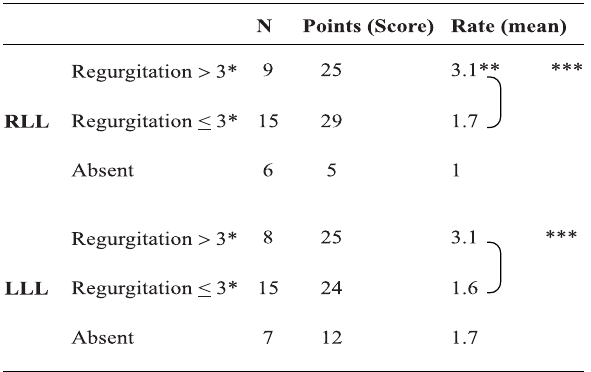
RLL and LLL: Right and Left Lower Limbs * Greater than 25.9 cm/s